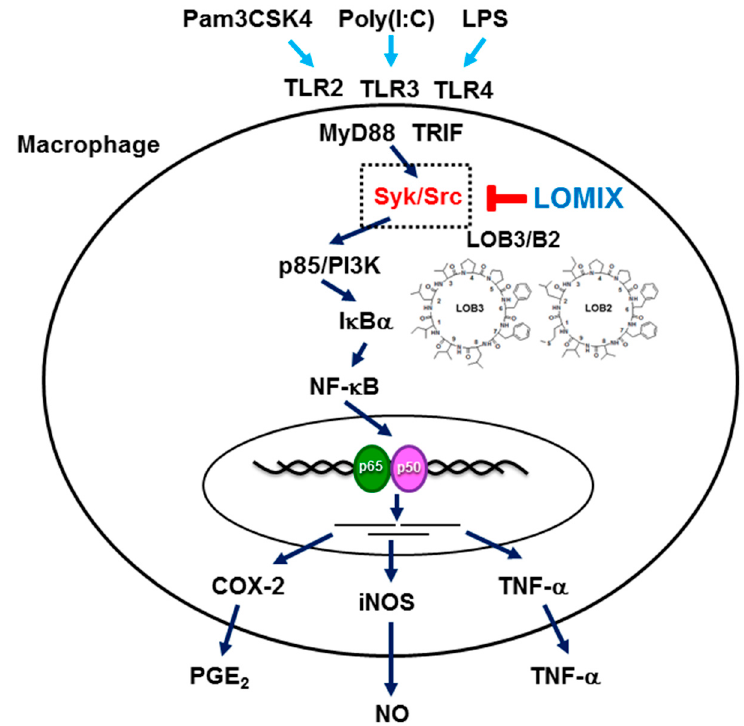
Figure 7. Schematic summary describing LOMIX-mediated anti-inflammatory activity in macrophages.